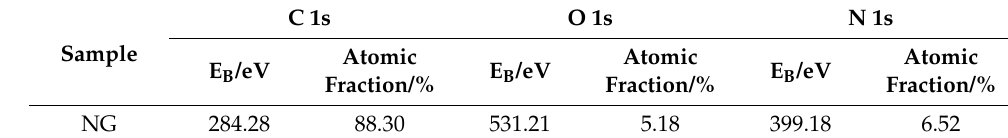
Figure 3. Analysis of morphology for PtRu/NG composite carbon nanofiber.